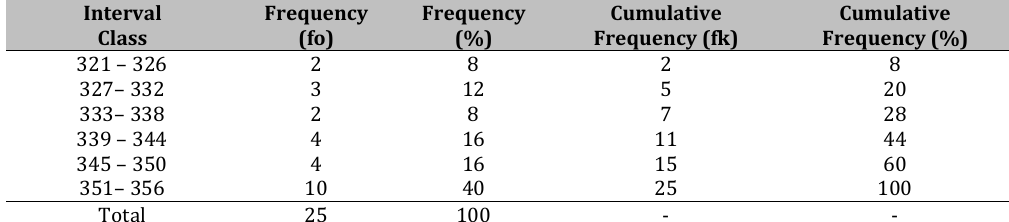
Table 5 Frequency Distribution of Relevance of Teachers’ Performance after Using Academic Supervision